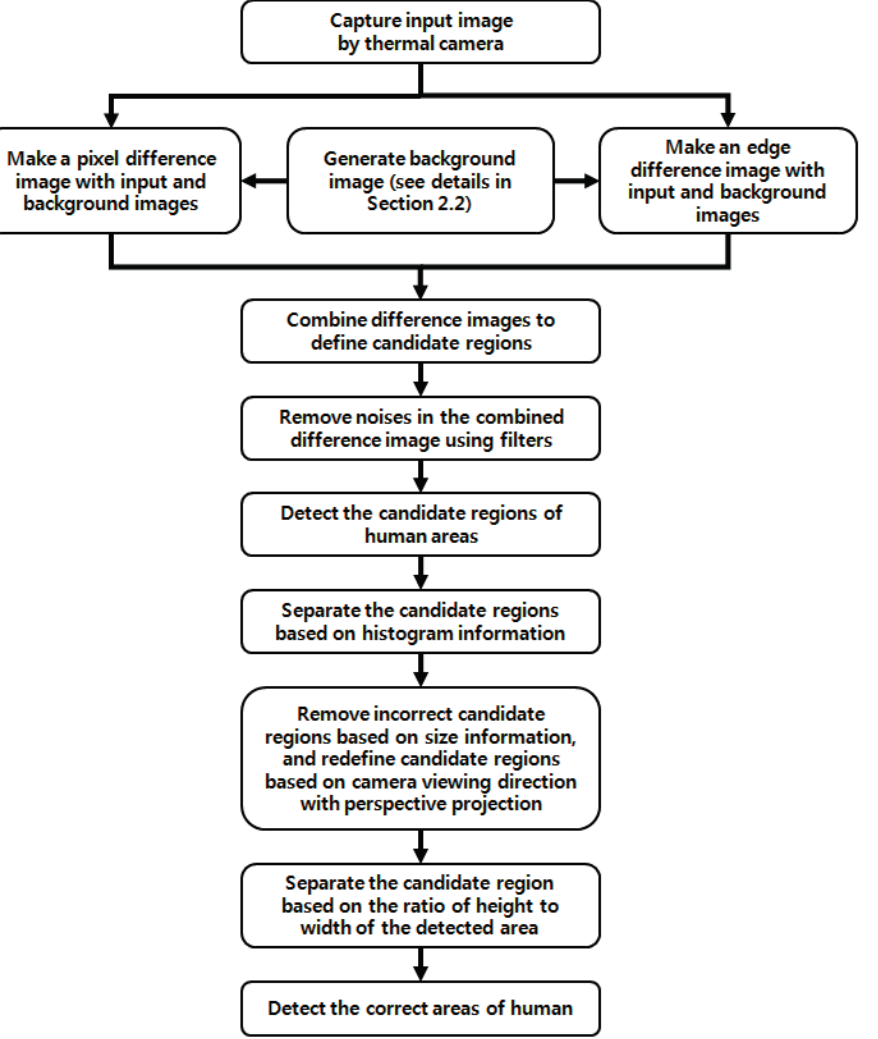
Figure 1. Overall procedure of the proposed